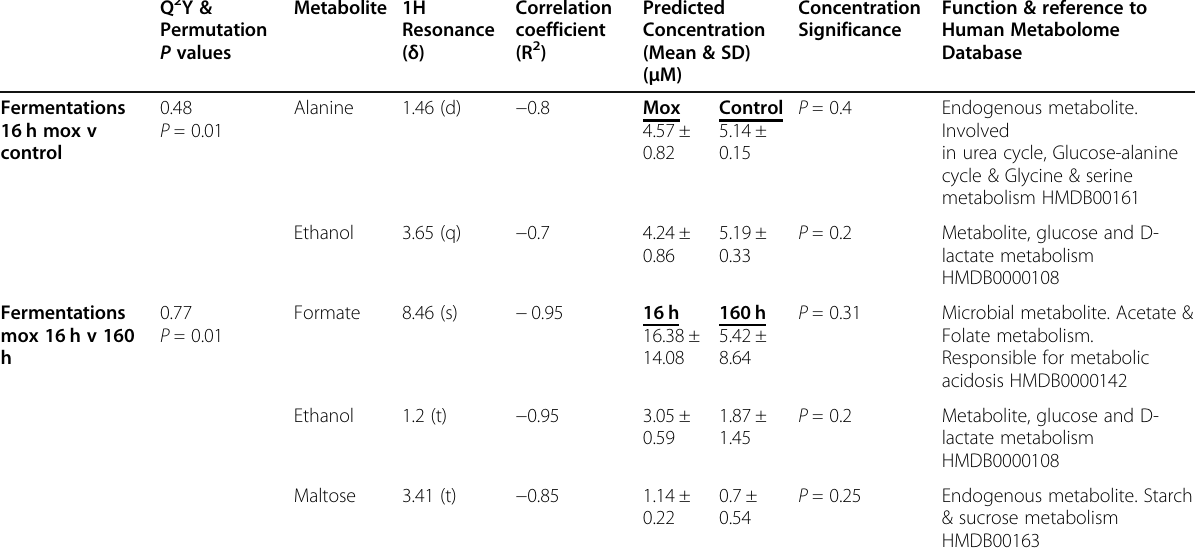
Table 2 Summary of OPLS-DA models, metabolites, resonances, concentrations and functions. Resonance key s; singlet, d; doublet, t; triplet, q; quartet. Metabolites referenced to Human Metabolome Database